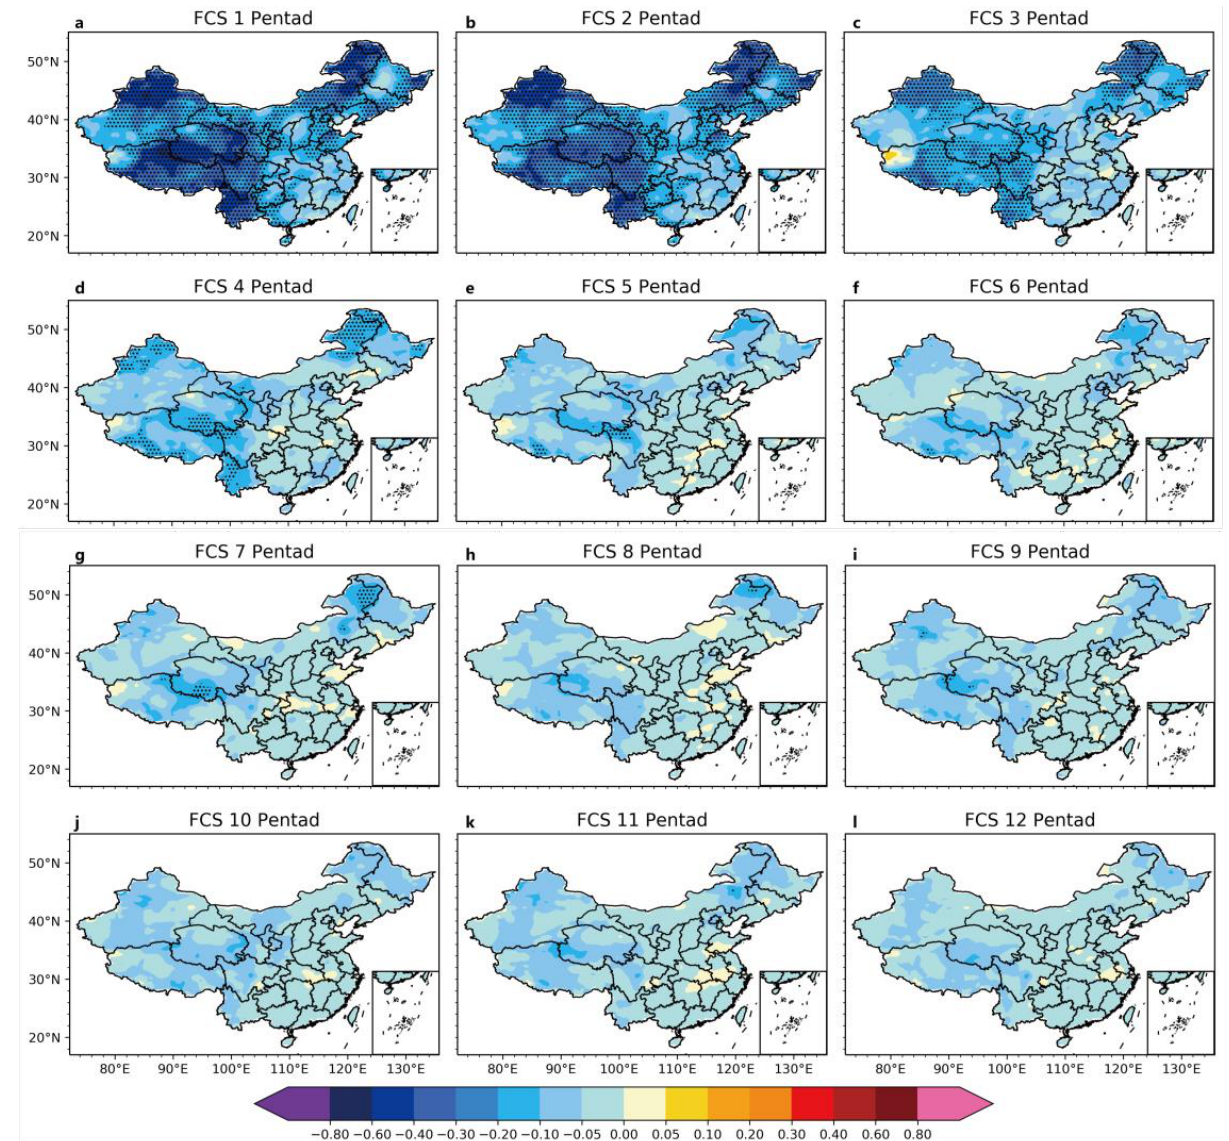
Figure 10. Spatial pattern of annual average MSSS for the 1–12 ( a – l , respectively) pentad precipitation forecast of the pentad DSDM from 2000 to 2018. The dotted regions are where the MSSS passed the 95% significance test.